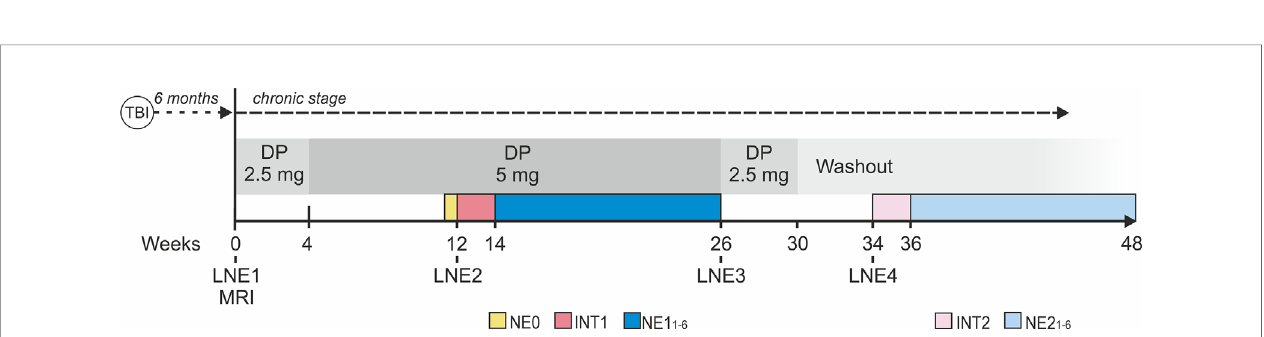
FIGURE 2 | Study design. A single-subject, open-label longitudinal design with drug and language interventions was used. DP, donepezil; TBI, traumatic brain injury; INT, intensive naming therapy; LNE, language and neuropsychological evaluation (1-4); NE0, baseline naming evaluation in which naming performance for the full set of treated and untreated words used in INT1 and INT2 was evaluated; NE, naming evaluations (1-6) performed after each INT; MRI, magnetic resonance imaging.